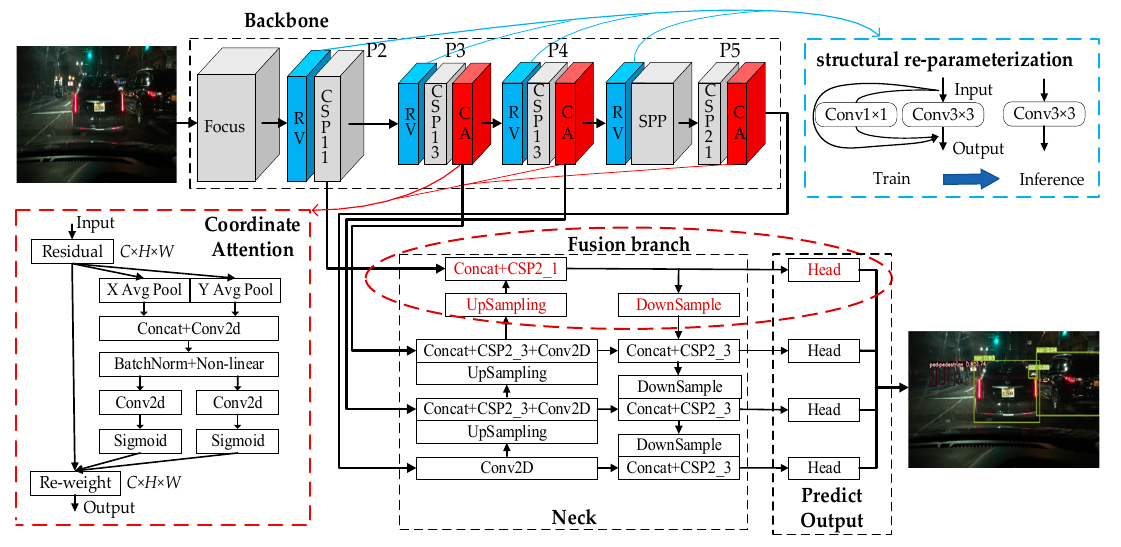
Figure 1. Structure of Improved YOLOX Model.